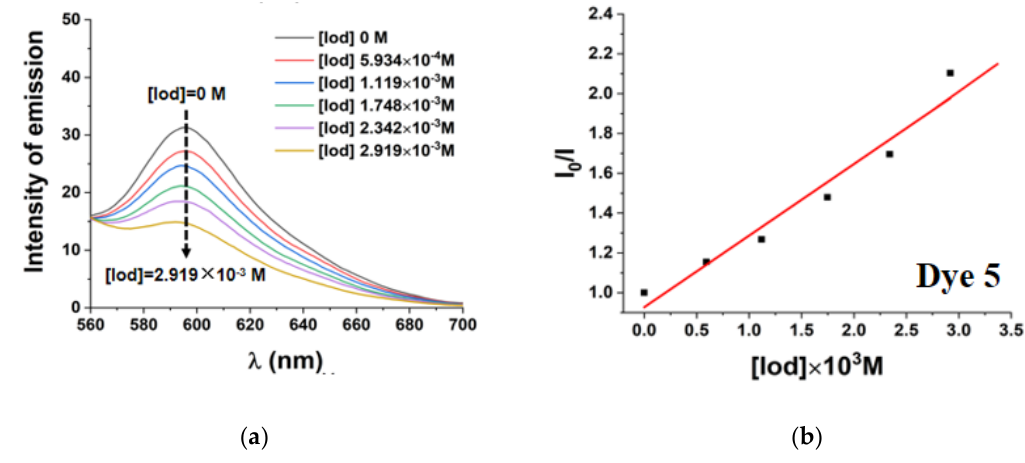
Figure 9. ( a ) Fluorescence quenching of dye 5 by iodonium salts; ( b ) Stern–Volmer treatment for the dye 5 / Iodonium salts fluorescence quenching.